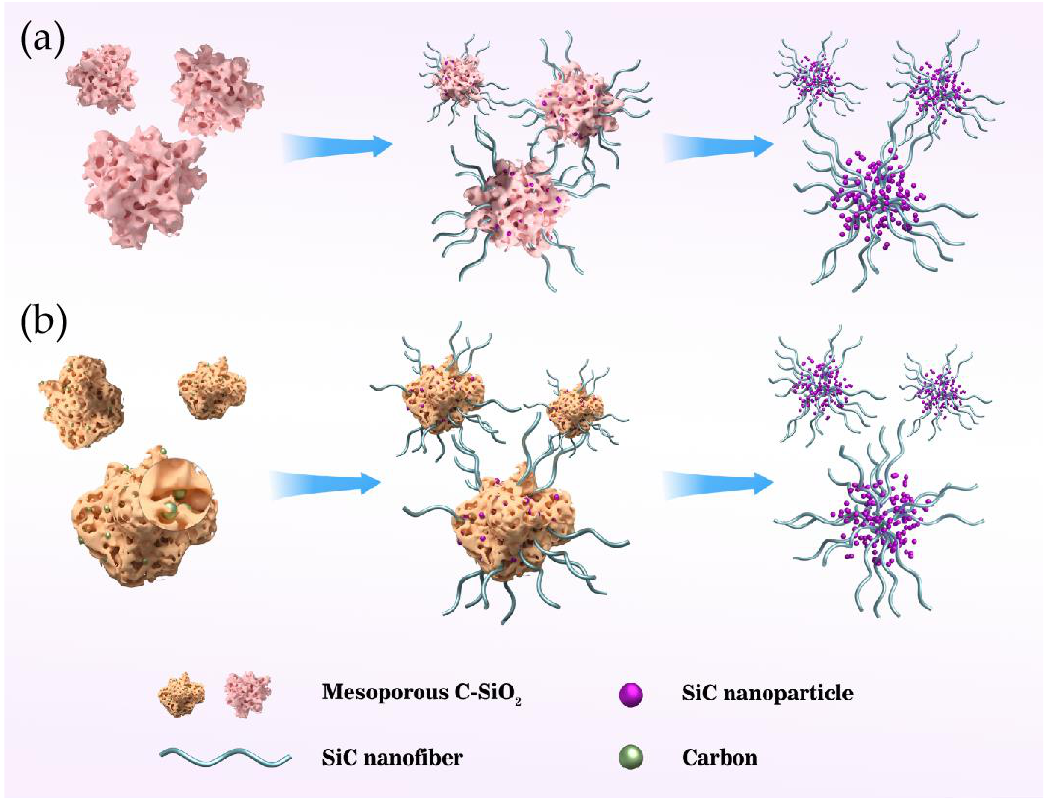
Figure 1. Schematic diagram of the formation of SiC nanostructures: ( a ) SiC nanofibers and SiC NPs synthesized by using mesoporous C-SiO 2 nanocomposites with a high C/SiO 2 ratio; ( b ) SiC nanofibers and NPs with mesoporous C synthesized by using SiO 2 nanocomposites with a low C/SiO 2 ratio and infiltrated with a small amount of carbon. Adapted with permission from Ref. [19]. 2007, American Chemical Society.